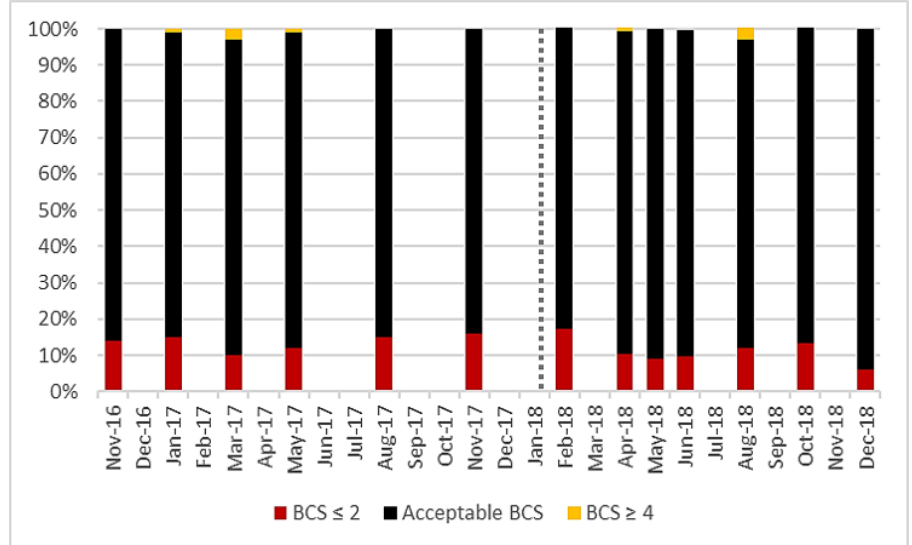
Figure 2. Prevalence of milking cows within the acceptable body condition score (BCS) range compared to over-fit or underweight cows observed at each BCS recording session for all lactating cows (101 ± 6) on the study farm from November 2016 to December 2018. Vertical dotted line represents AMS installation.